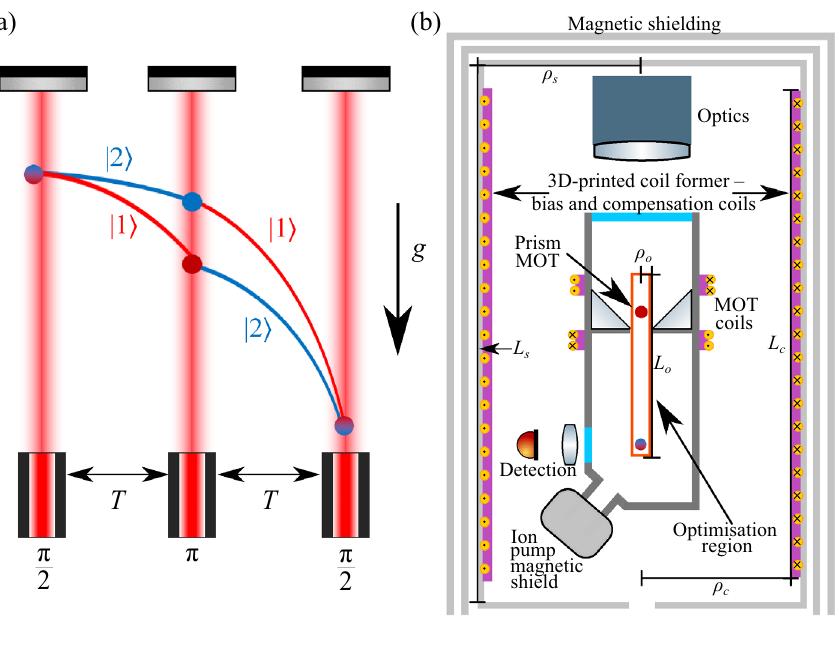
Figure 2. ( a ) Gravity, g , is measured using a Mach–Zehnder atom interferometry sequence 19 . The atom cloud is prepared in one of two atomic energy and momentum states, | 1 � and | 2 � , and then is put into a quantum superposition of these states using stimulated Raman transitions. The states are allowed to evolve for a time T , before being swapped using a mirroring pulse and finally mixed after a further evolution time T . Due to the phase shift of the atom–light interaction, the sequence is sensitive to acceleration along the axis of the interrogation beams. These beams are aligned to the direction of gravitational acceleration. The value of gravity is proportional to the interferometer phase which is encoded in the state populations. ( b ) Schematic of the interferometer’s magnetic shield and atomic measurement package, with the regions relevant to the specification of the coil system highlighted. The coil system sits inside the interferometer’s magnetic shield and outside the measurement package. The coil system is designed to generate target fields in the optimisation region shown by the red